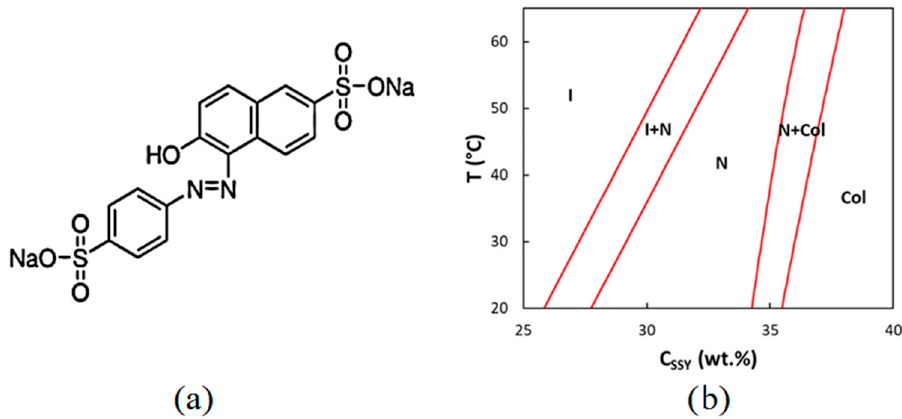
Figure 2. ( a ) DSCG molecular structure and ( b ) its phase diagram. Reprinted with permission from ref. [19]. Copyright 2011, Taylor & Francis.